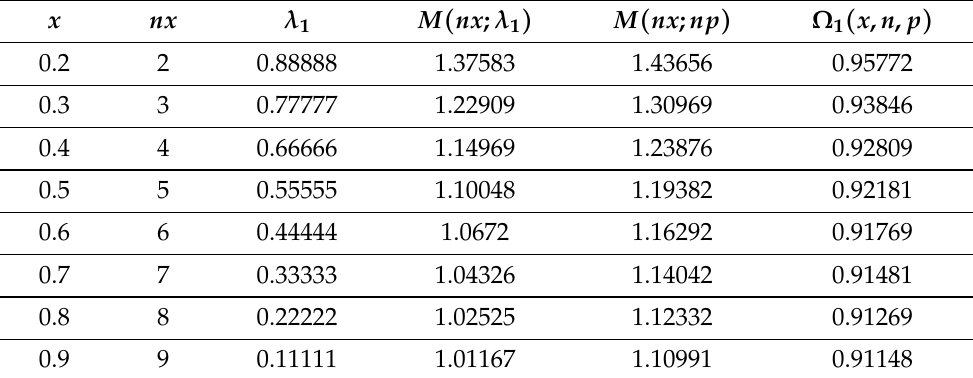
Table 3. Values of M ( nx ; λ 1 ) , M ( nx ; np ) and Ω 1 ( x , n , p ) for n = 10, p = 0.1, x = k